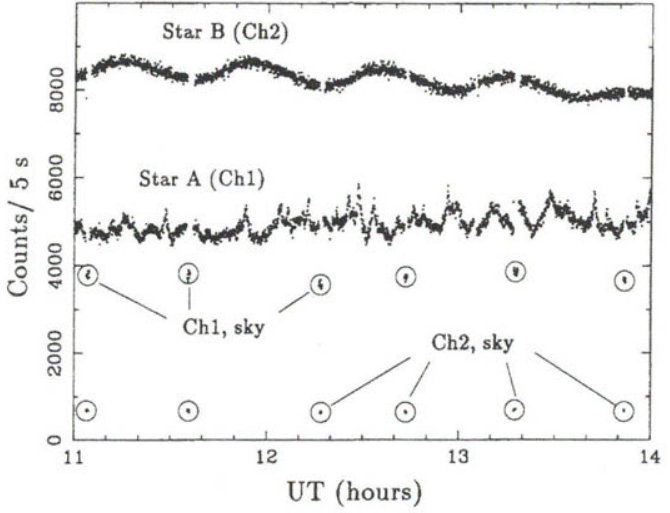
Fig. 1. Three hours of raw high-speed photometry on two stars ob- tained at MJUO during the XCOV7 campaign in 1992. Star A is the CV 1H 0857-242, the principal target of the WET campaign, while star Β is a nearby "constant" comparison star, CD —24°7599. The circled points represent sky counts in each